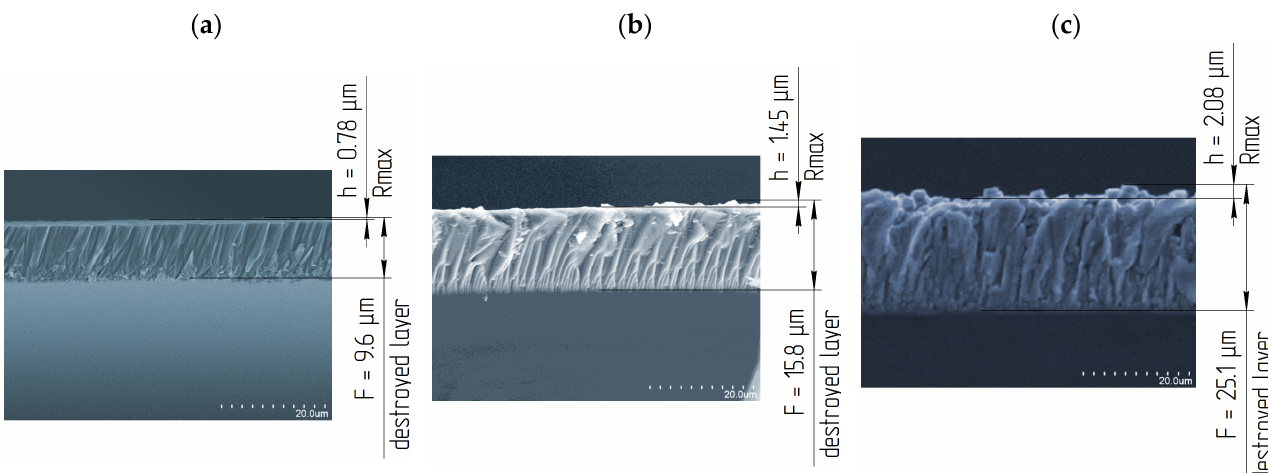
Figure 9. Deformed layer of LNSCplates after lapping on glass lapp of the LK5 mark with 24A suspensions, grain size:( a ) М 3; ( b ) М 7; ( c ) М 14.